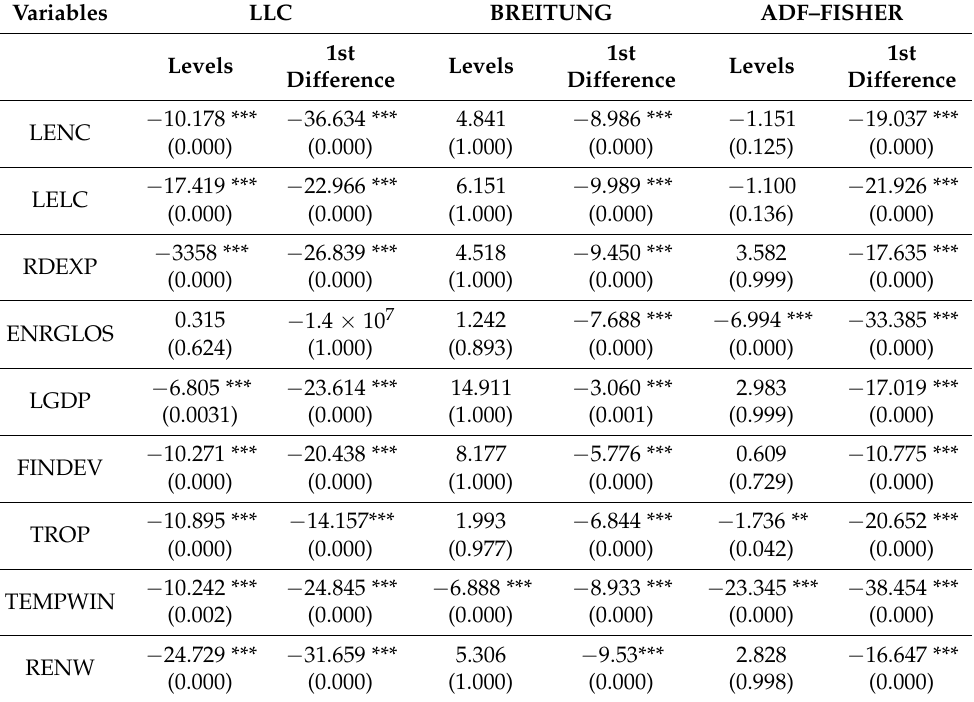
Table A2. LLC, BREITUNG, and ADF–FISHER unit roots test at levels and first